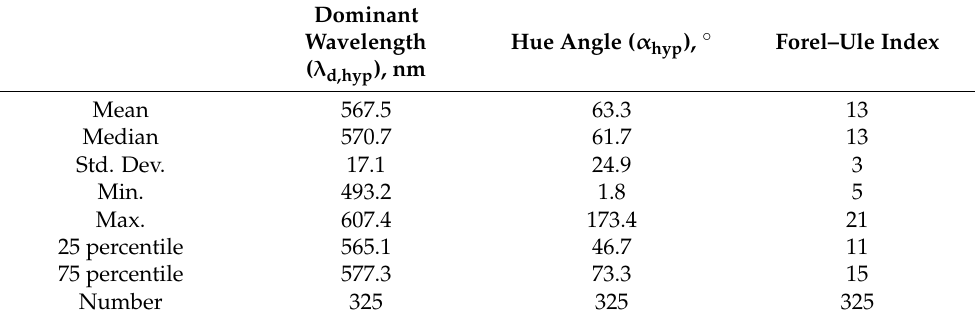
Table 1. Summary statistics for the dominant wavelength, hue angle, and Forel–Ule index for the in situ hyperspectral